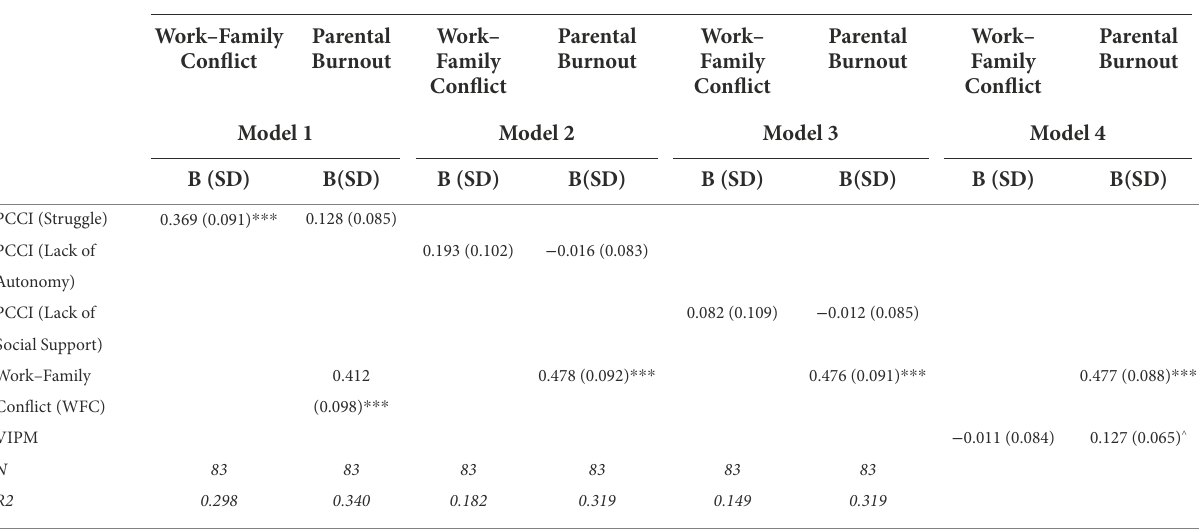
TABLE 4b Hayes mediation analysis on parental burnout (Y) with Work–Family Conflict (M) and PCCI (X; including all controls, results not shown) at Time-2